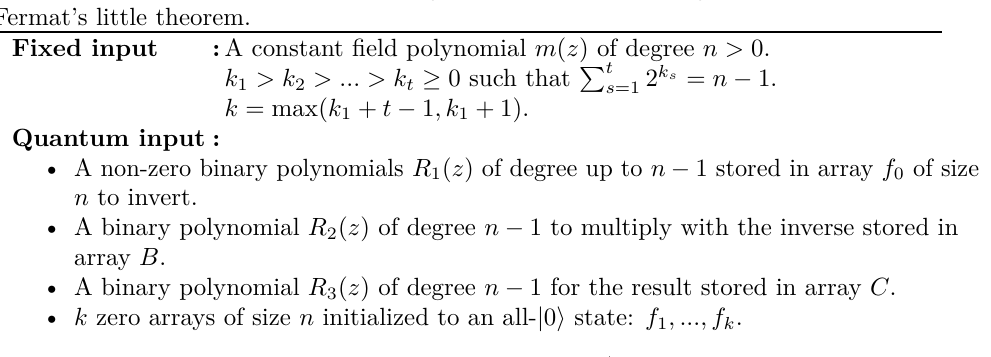
Algorithm 2: FLT_DIV. Reversible algorithm for division using inversion with Fermat’s little